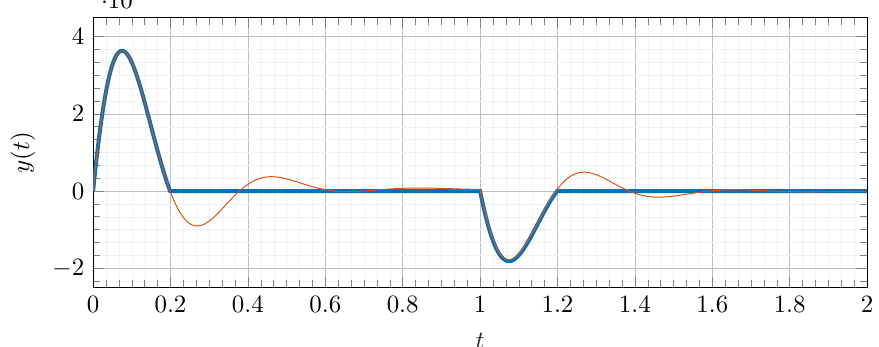
Figure 7. Closed-loop response y under a disturbance signal: (orange thin line) base PI controllers; (blue thick line) PI + CI